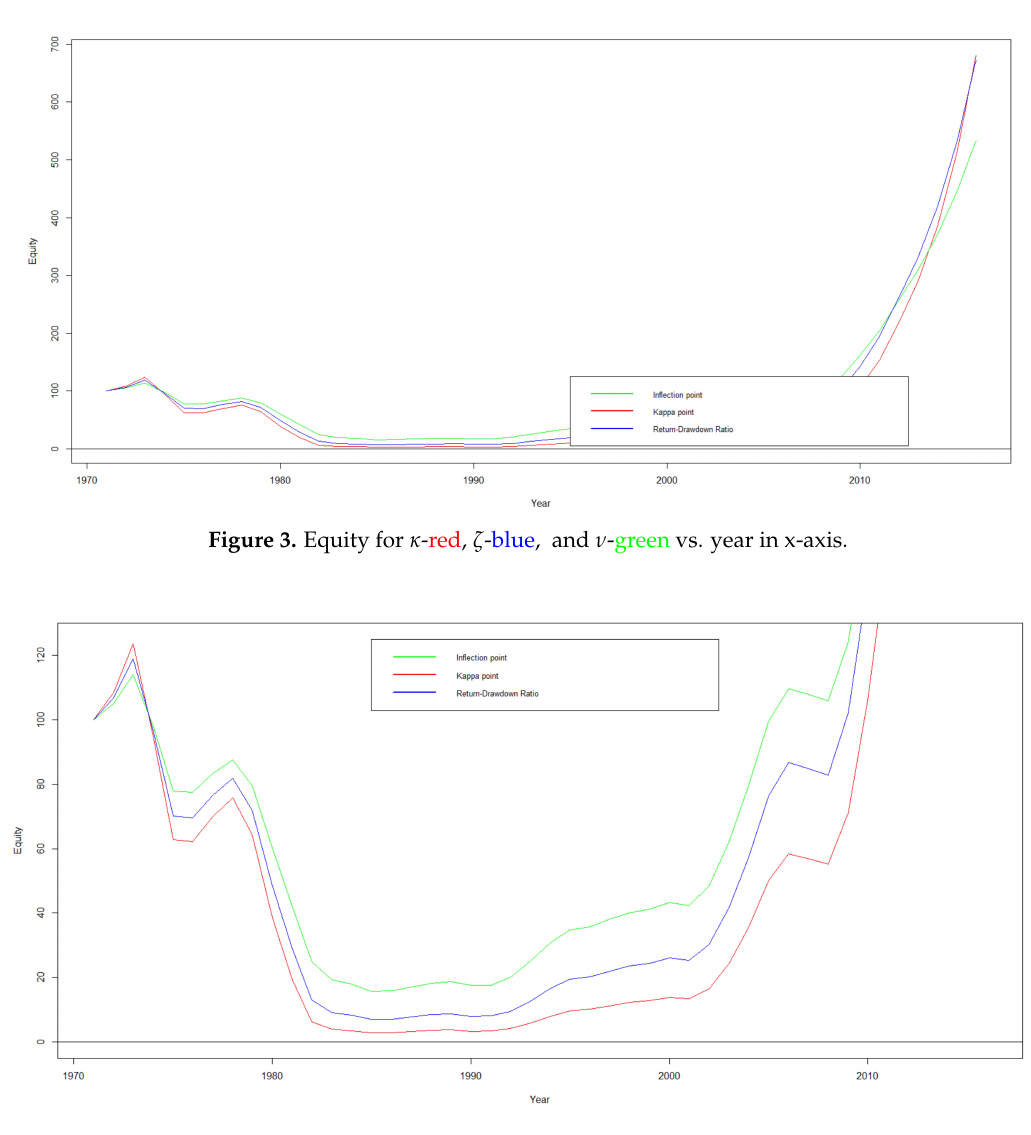
Figure 4. Equity κ -red, ζ -blue, and ν -green vs. year in x-axis